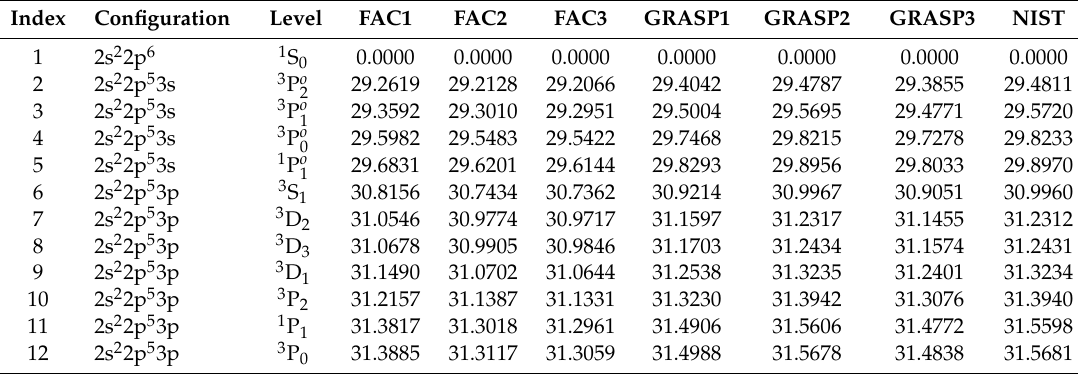
Table 3. Comparison of energies (in Ryd) for the lowest 37 levels of Sc